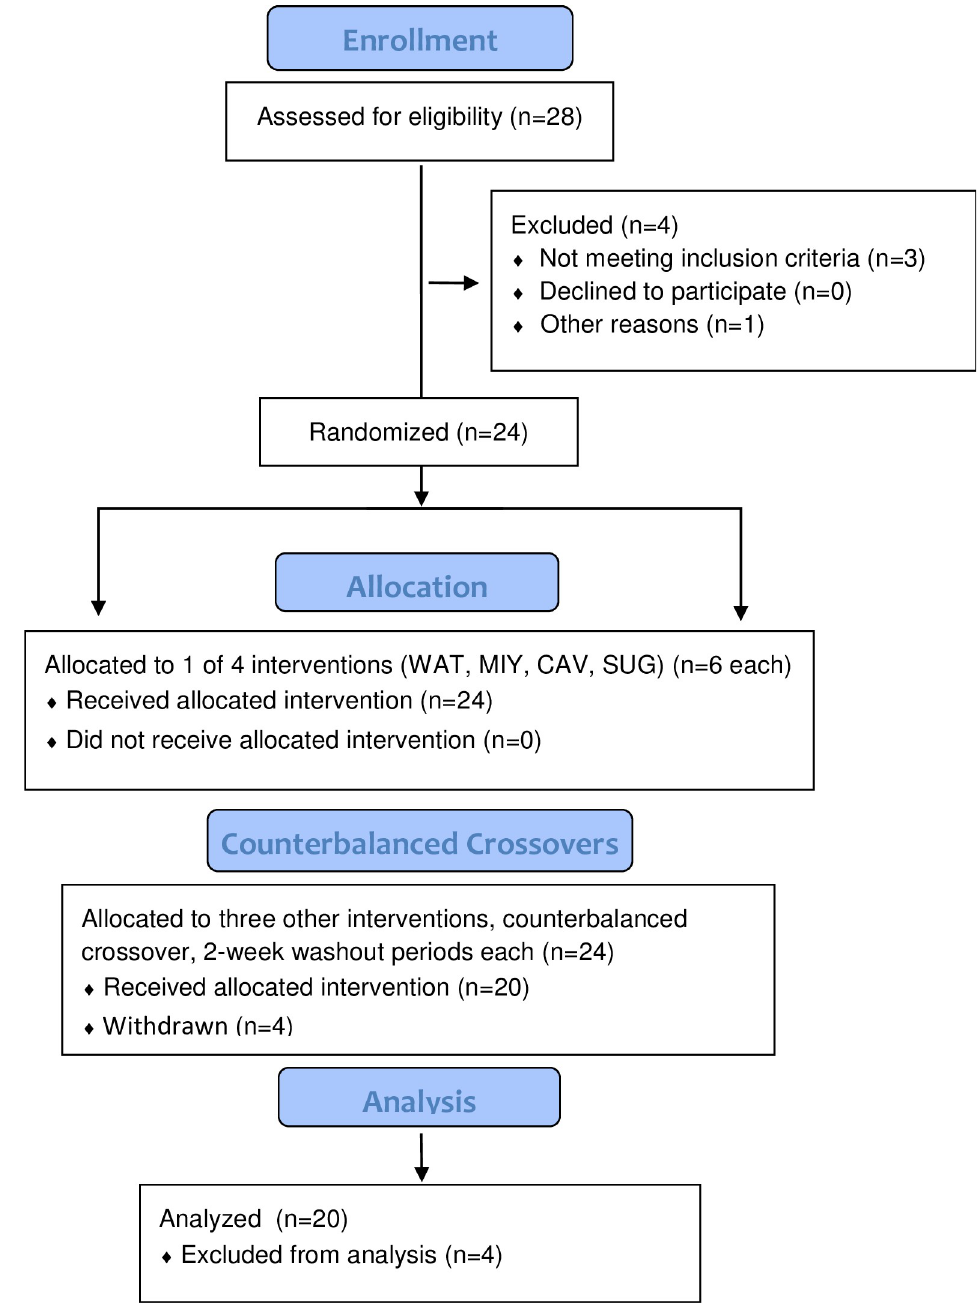
Fig 1. Study participant flow diagram. WAT = water trial; MIY = mini-yellow banana trial; CAV = Cavendish banana trial; SUG = sugar beverage trial. Four study participants randomized into the study failed to complete all four arms of the study (three due to changes in personal schedules and one to a training-related